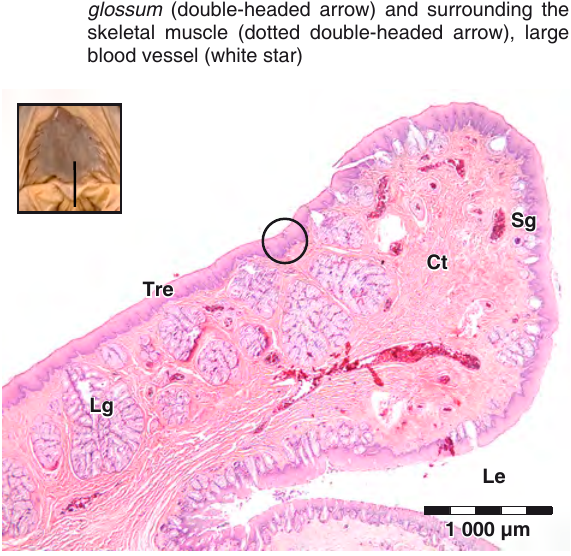
FIG. 12 Median longitudinal section of the tongue root depicting small, simple tubular glands (Sg), and large, simple branched tubular glands (Lg). Connective tissue (Ct), laryngeal entrance (Le), tongue root epithelium (Tre), encircled area is enlarged in Fig.